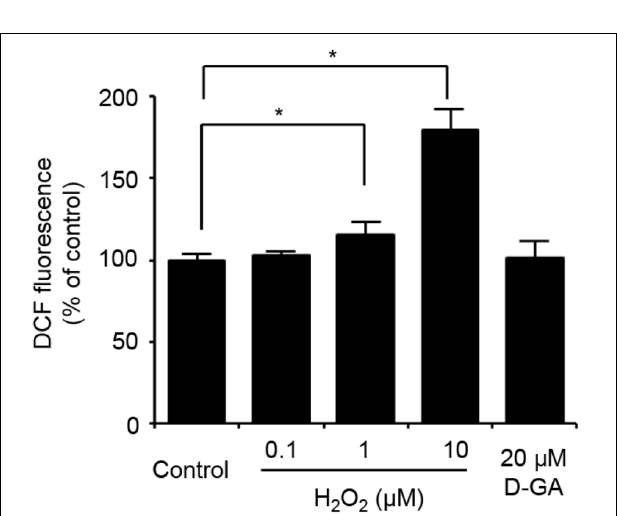
FIGURE 7 | No ROS generation results from D-GA treatment in LN215 cells. LN215 cells were plated in 96-well plates and grown to full confluency. After washing with C-solution, the cells were loaded with 10 µ M DCFH-DA diluted in C-solution for 1 h before fluorometry. H 2 O 2 or D-GA was added after 30 min or 10 min before the measurement, respectively. The data are the mean ± SD ( n = 3). ∗ p < 0.05 (Student’s t -test). and 10.6% ± 5.9% ( n = 10, mean ± SD) in the